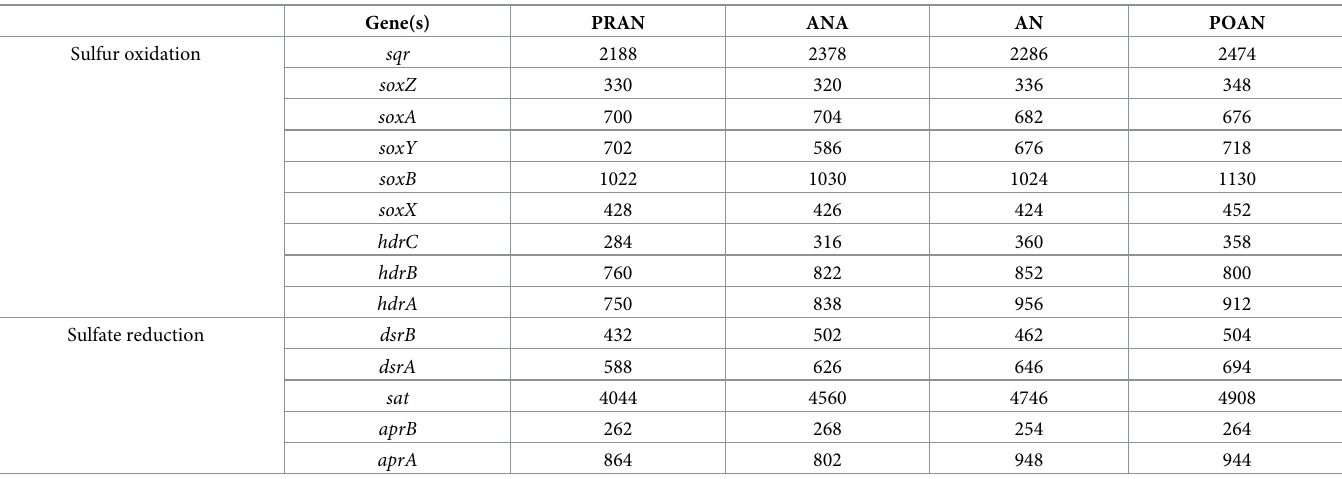
Table 2. Sulfur oxidation and sulfate reduction genes in the sludge